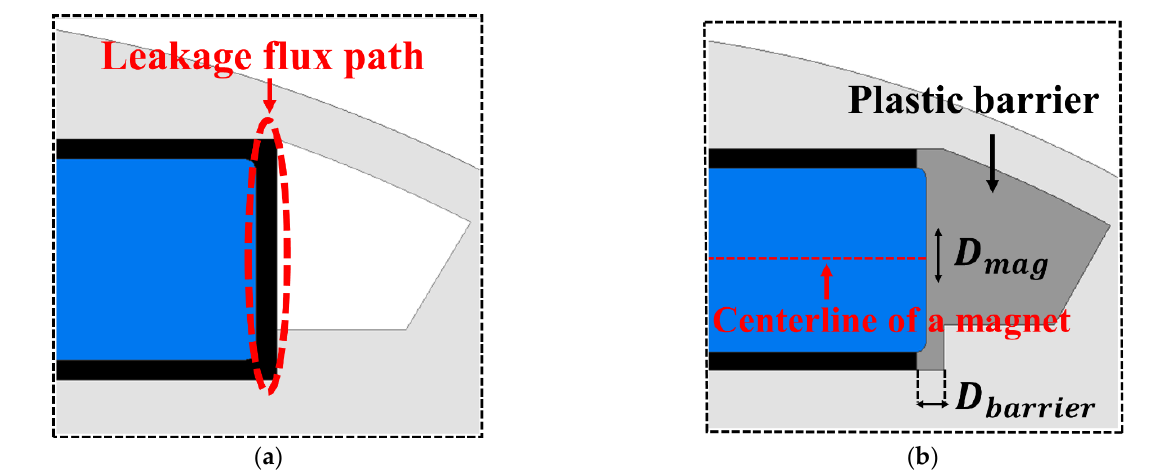
Figure 8. Setting of design variables: ( a ) leakage flux path; ( b ) design variables.